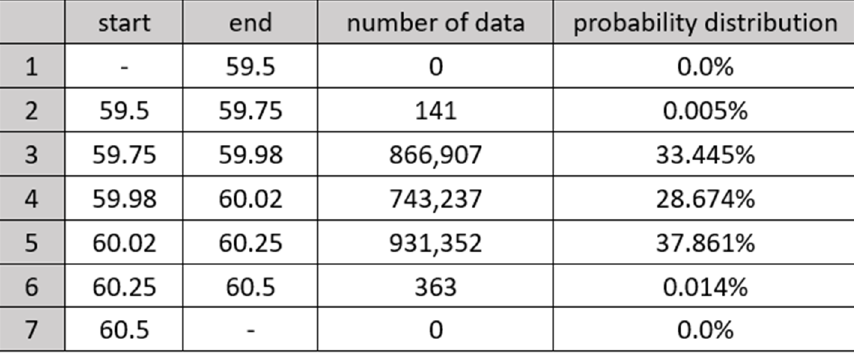
Figure A4. Frequency distribution of March 2020.